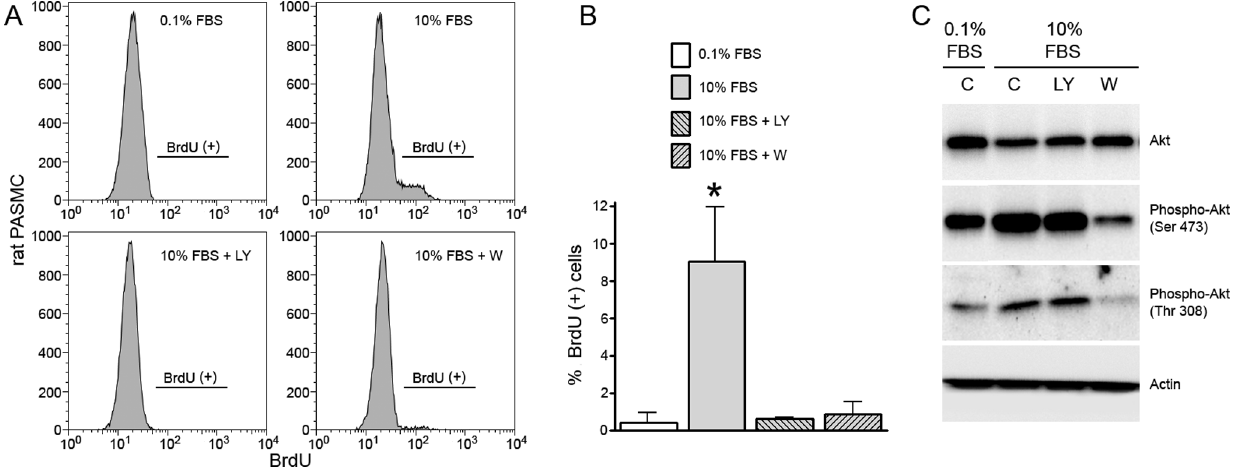
Figure 6. PI3-kinase inhibitors, LY294002 and wortmannin, inhibit rat PASMC proliferation, but only wortmannin inhibits AKT phosphorylation. Rat PASMC were grown to confluence, growth arrested in 0.1% serum for 72 hours, and then exposed to 10% or fresh 0.1% FBS in the presence or absence of wortmannin (W) or LY294002 (LY). Cells were examined 24 hours later for BrdU incorporation (A and B) and AKT phosphorylation (C), (n=3 experiments, * indicates p , .05).